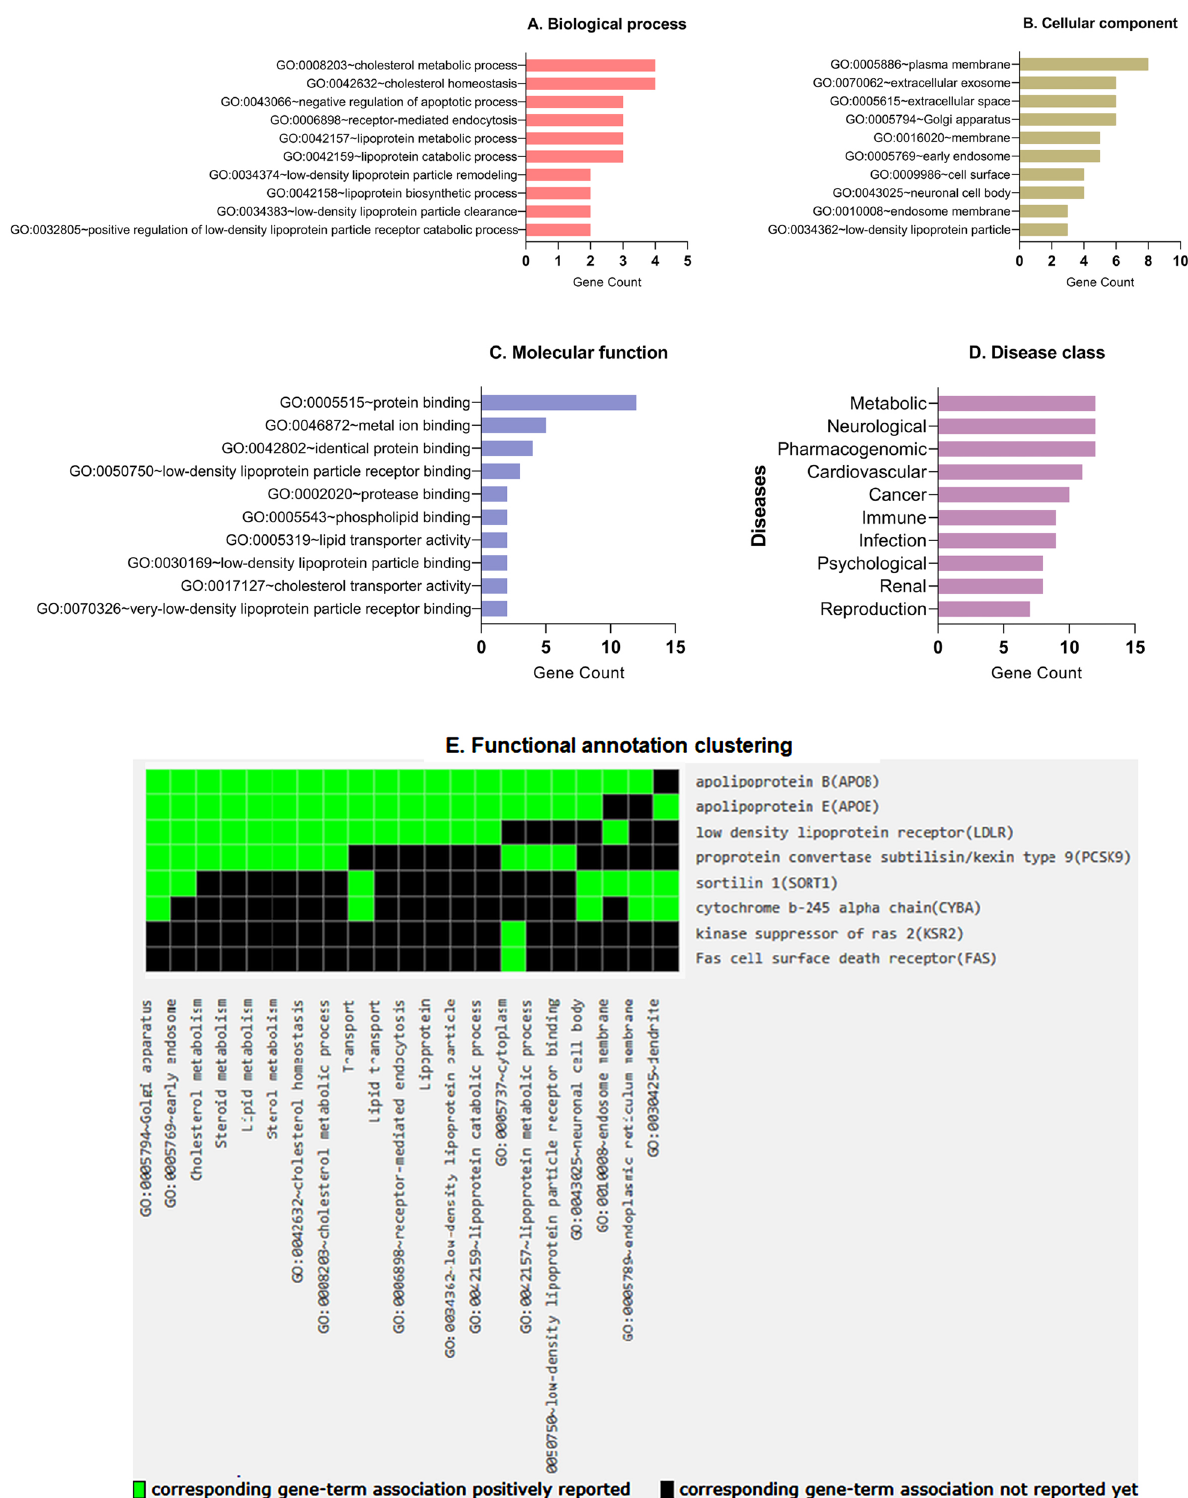
Figure 6. Gene ontology (GO) annotation. The top 10 GO terms in each category. ( A ) Biological process. ( B ) Cellular component. ( C ) Molecular function. ( D ) Disease class. ( E ) Functional annotation